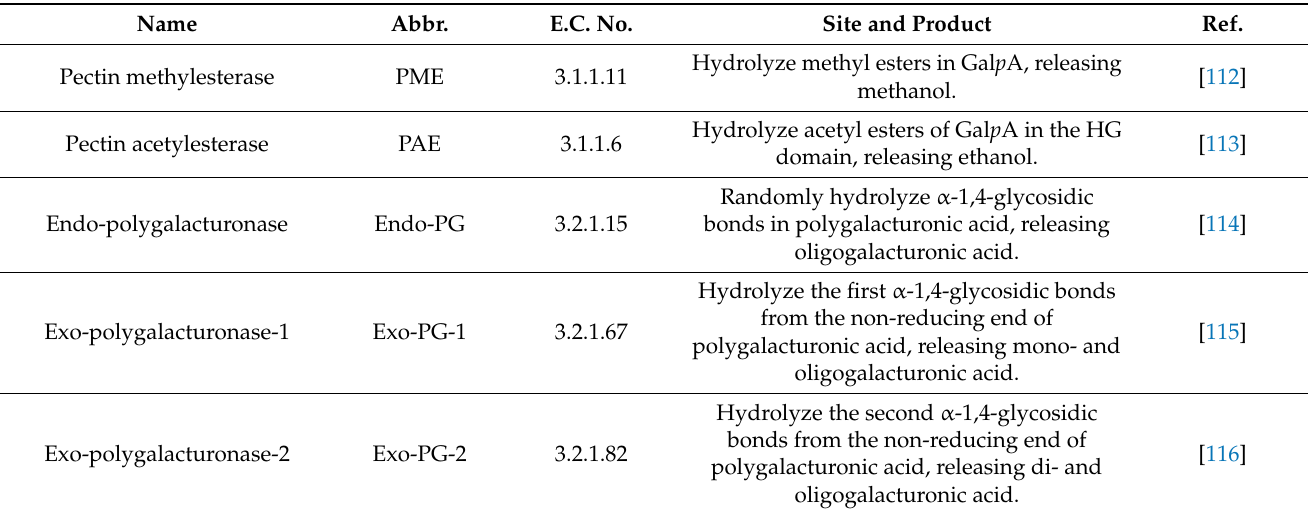
Table 2. Enzymes used in enzymatic